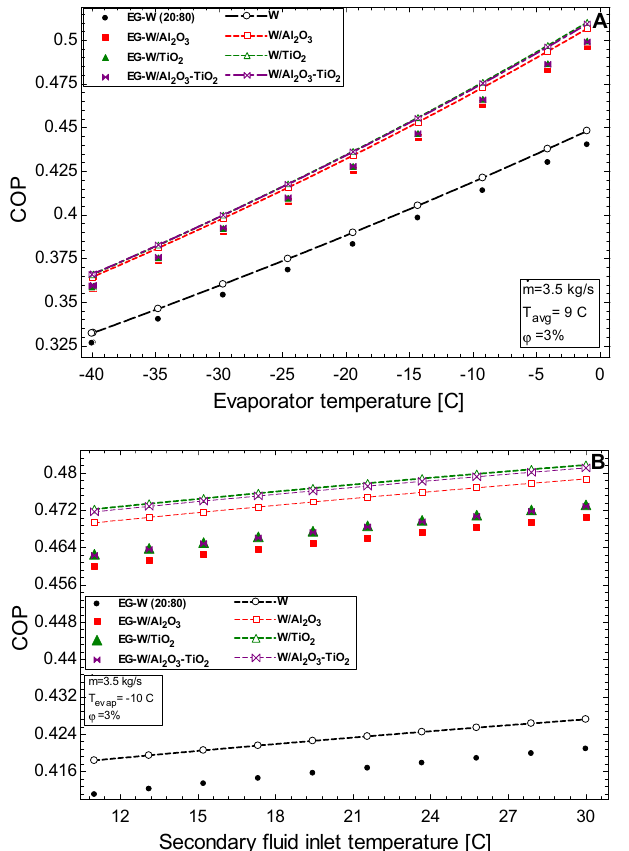
Figure 10. Effect of ( A ) evaporator temperature and ( B ) secondary fluid inlet temperature on the COP of the